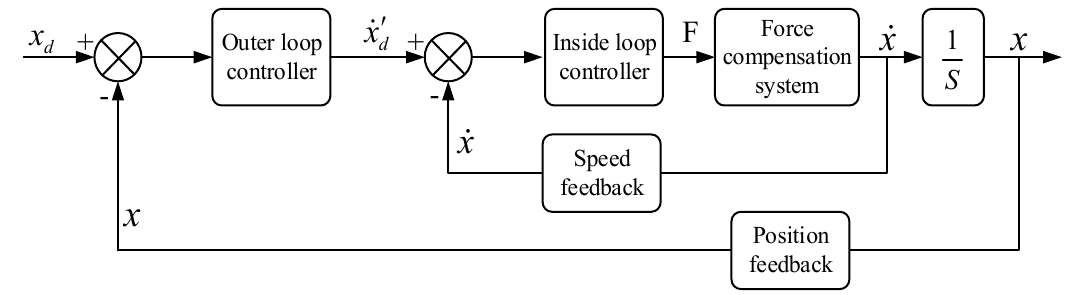
Figure 10. Structure of a two-loop sliding mode control system.